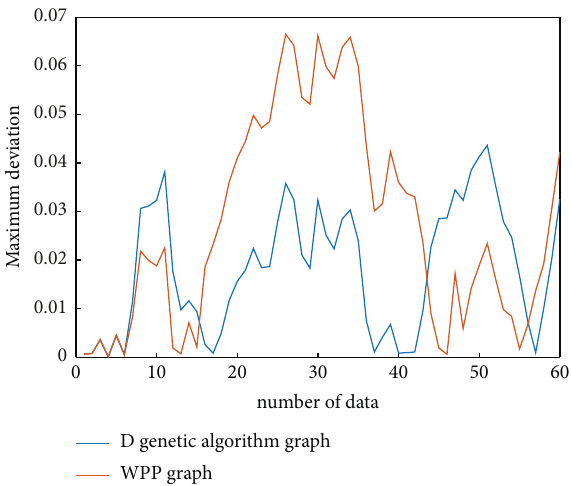
Figure 10: Comparison of deviation values between D genetic algorithm and WPP graph